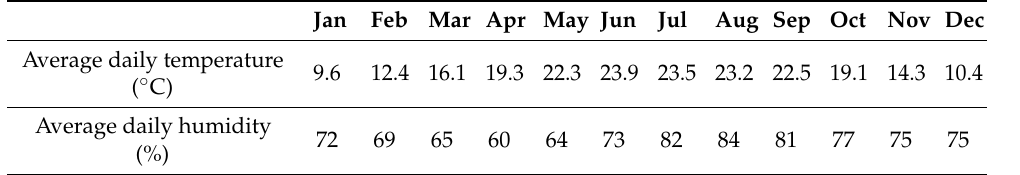
Table 1. Kathmandu